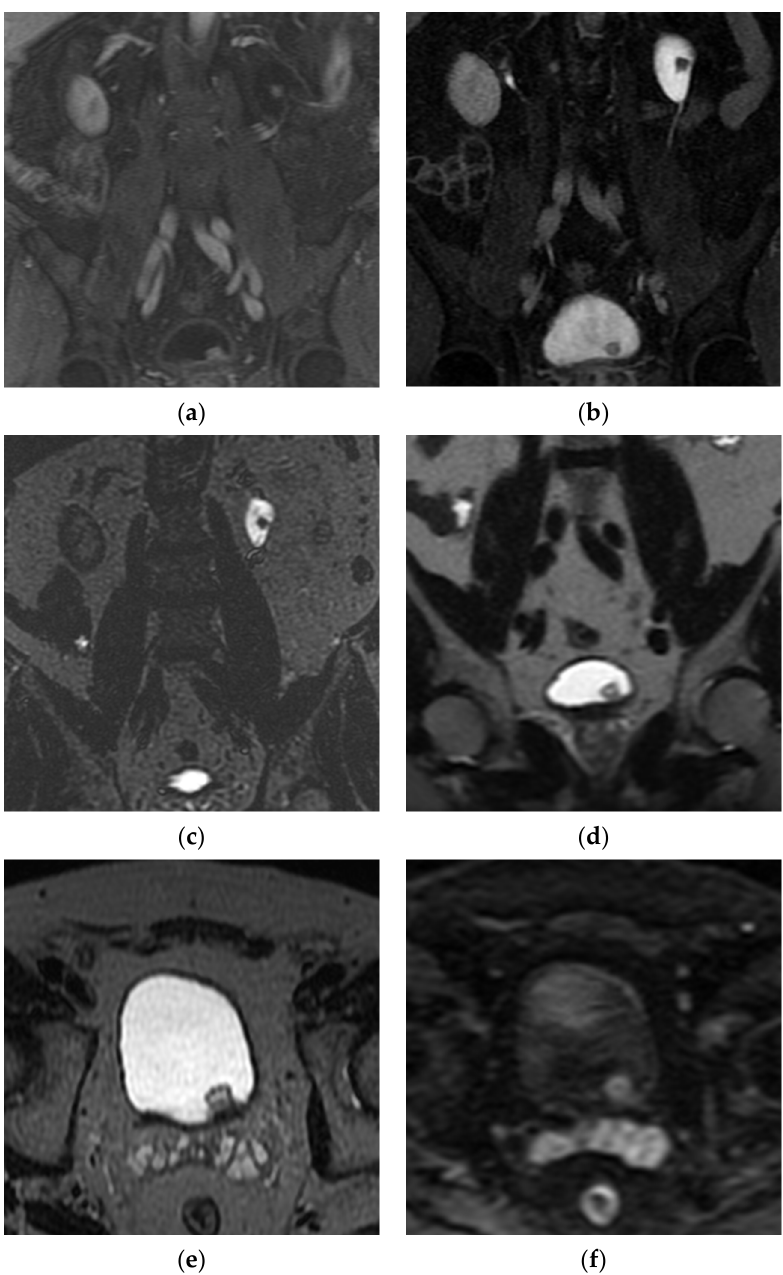
Figure 6. MR urography obtained in a patient with Lynch syndrome showing synchronous upper and lower tract lesions. Pathology of the bladder lesion confirmed non-invasive urothelial carcinoma and upper tract washings were concerning for low grade urothelial carcinoma. ( a ) Coronal post-contrast T1WI shows enhancing lesions in the bladder (solid white arrow) and left renal pelvis (dashed white arrow). ( b ) Coronal post-contrast excretory phase image shows the lesions as filling defects, surrounded by excreted contrast. ( c ) Coronal T2WI shows the upper tract lesion surrounded by T2 hyperintense urine. ( d ) Coronal T2WI of the bladder shows the bladder lesion as T2 intermediate in signal without invasion into the T2 hypointense muscularis propria. ( e ) Axial T2WI of the bladder shows the mass to be non-invasive. ( f ) Axial DWI shows restricted diffusion of the mass. In 2018, a panel of experts created the Vesicle Imaging Reporting and Data System (VI-RADS) to standardize imaging and reporting [26]. It consists of a 5-point scale to suggest the risk muscle invasion based on T2WI, DWI, and DCE sequences (Table 2).